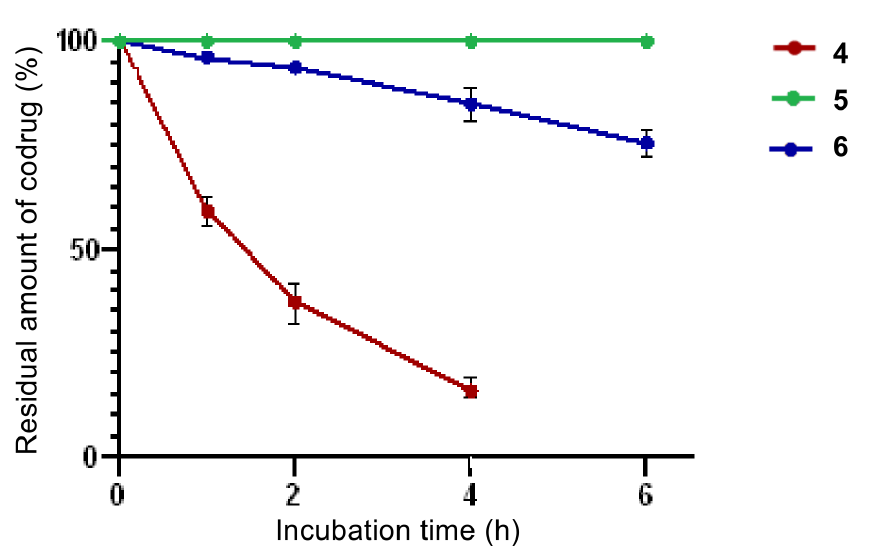
Figure 4. Human plasma stability of conjugates 4 – 6 . Plasma was collected at selected times (1, 2, 4 and 6 h). Upon incubation at 37 ◦ C the residual percentage - of each compound was determined by liquid chromatography-mass spectrometry (LC-MS) analysis. Each analysis was performed in